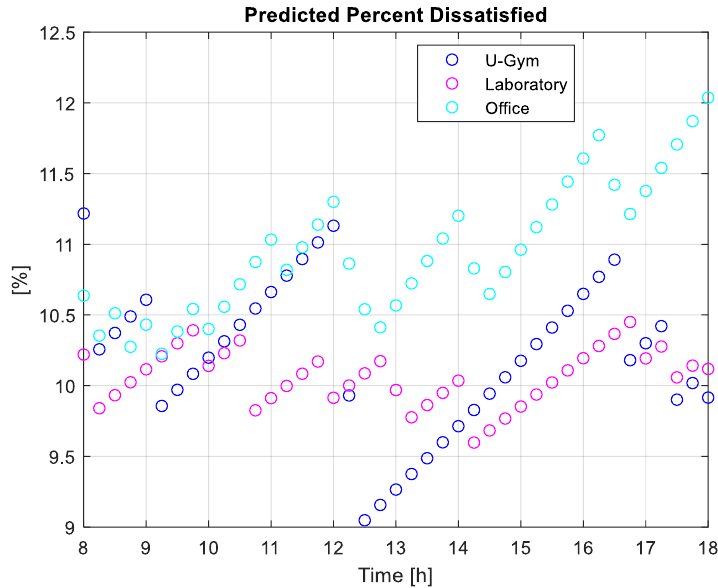
Figure 17. Predicted percent dissatisfied values.